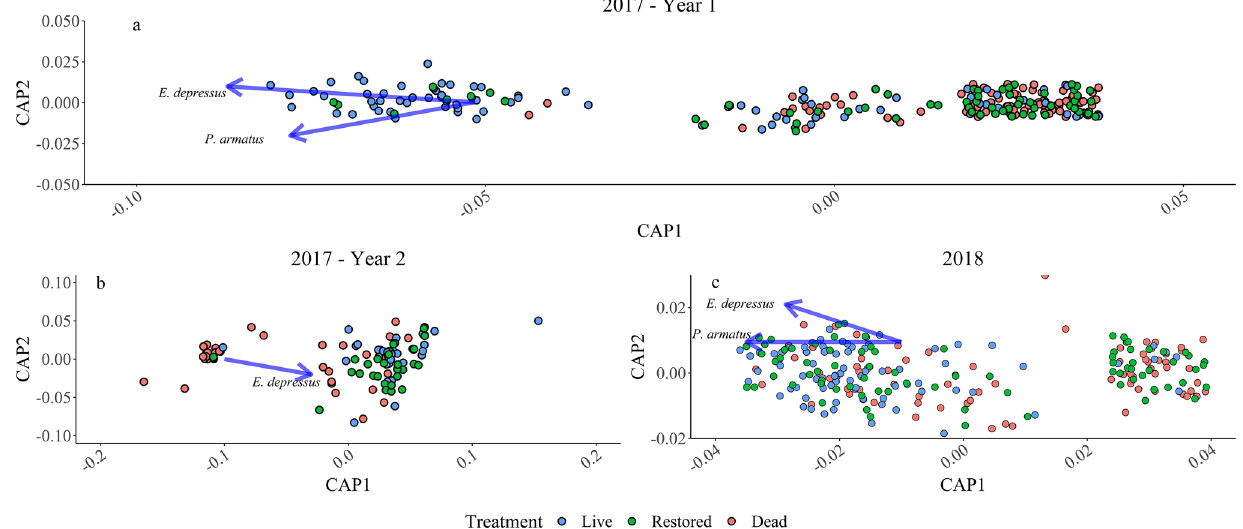
Figure 5. Canonical analysis of principle coordinated revealed meaningful effects of restoration on species composition. Overlayed vectors represent correlations of r = 0.8 or greater between CAP axes and species abundance. Eurypanopeus depressus abundance correlated with the effects of restoration in all ordiantions. Thus, E. depressus was selected as an indicator of restoration success.